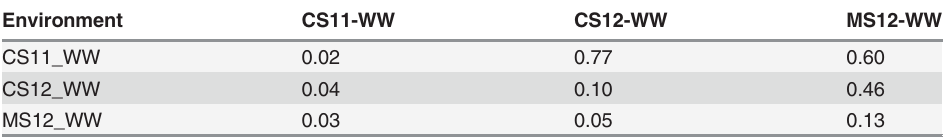
trials. The elements off the diagonal in the upper half of the matrix represent the speci fi c genetic correlation for each pair of